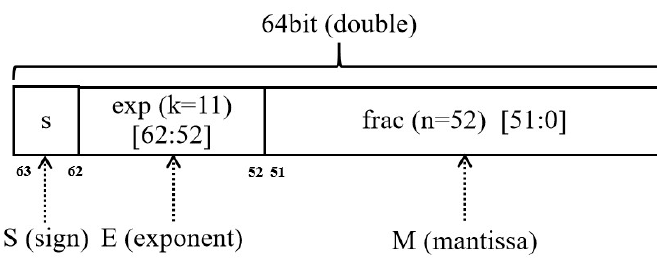
Figure 2. The storage format of FP64 in computer.